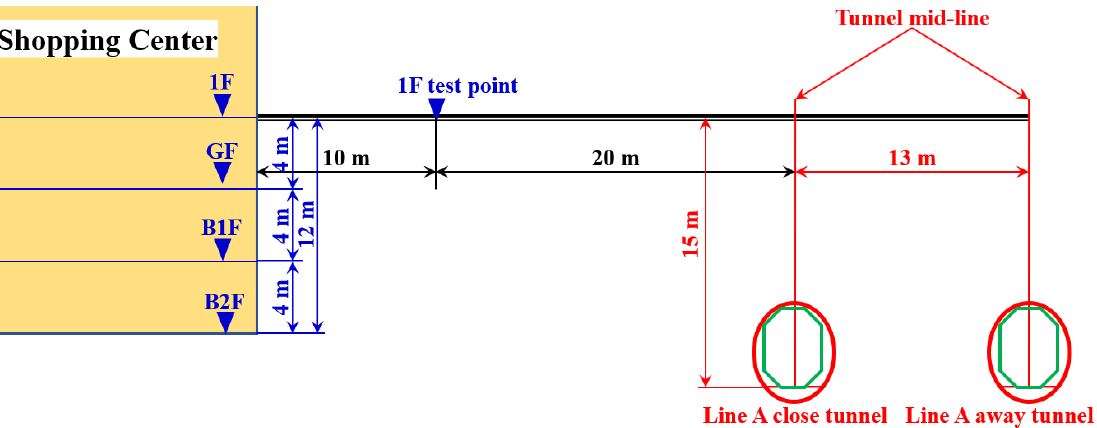
Figure 12. Cross-section diagram of mutual position relationship between the shopping center and Metro Line A.